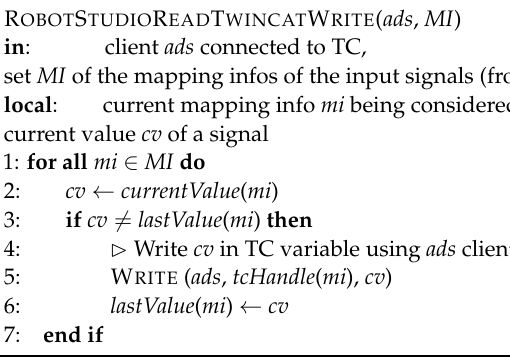
Algorithm 2 Update variables in